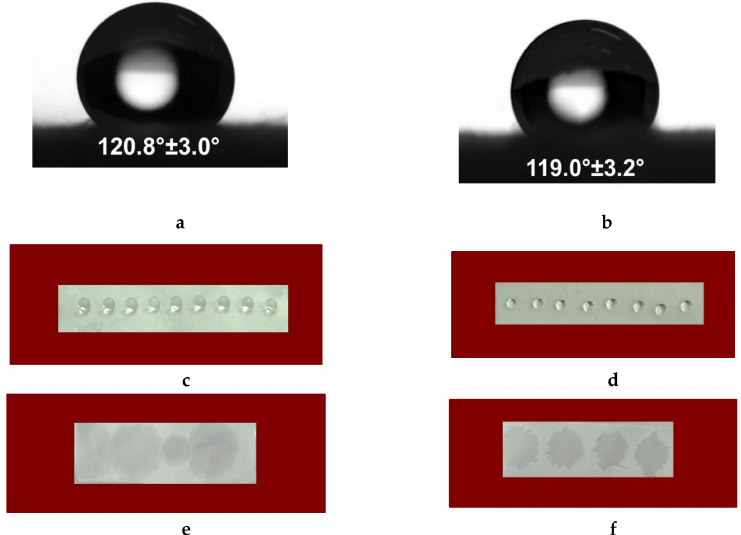
Figure 3. Digital images of water droplets (10 µ l) deposited on the membrane surfaces and contact angle values for membranes from ( a ) and ( c ) CA, ( b ) and ( d ) CA / 5-Cl8Q, ( e ) CA / PEG and ( f ) CA / PEG / 5-Cl8Q.